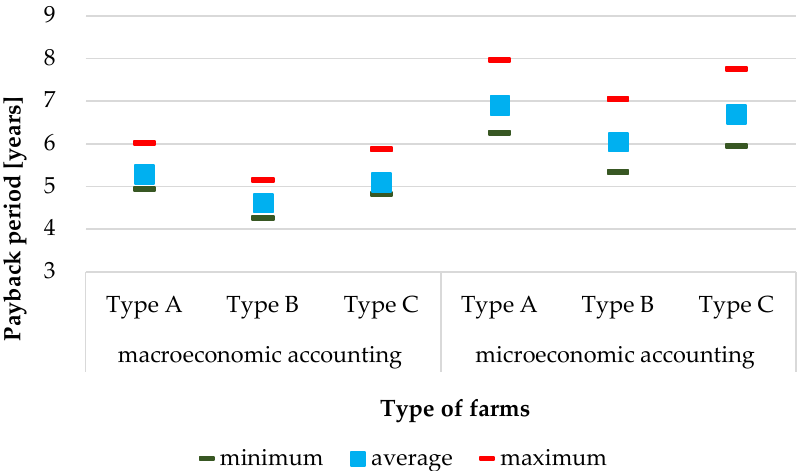
Figure 2. Statistical values of the payback period from investment in macro- and microeconomic accounting depending on the farm type .